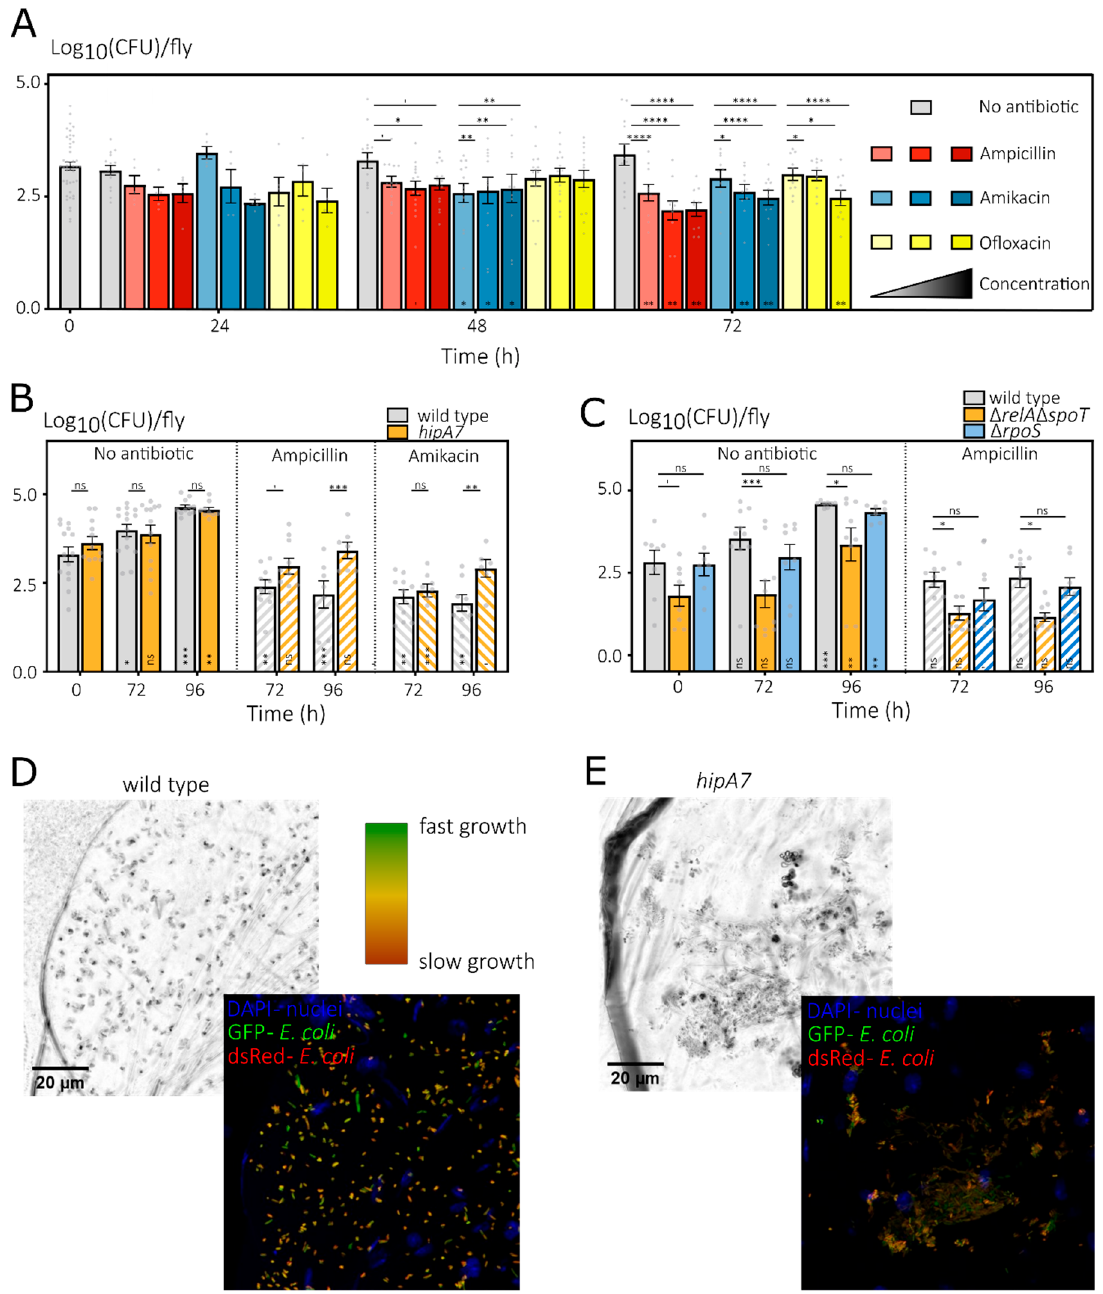
Figure 3. E. coli shows high in vivo antibiotic tolerance inside the gut of D. melanogaster, with in vitro identified persistence mutants showing mixed results during in vivo antibiotic treatments. ( A ) When treating D. melanogaster associated with the SX43 E. coli wild-type strain with AP (red), AM (blue) and OF (yellow) at 3 different concentrations (100, 400 and 1000 for AP and AM or 10, 40 and 100 µg mL − 1 for OF, all in different intensities) via liquid food in the CAFE assay, bacterial loads only start to decrease at 48 h and more consistently at 72 h. Bacterial loads are normalized per fly (means ± SEMs with n ≥ 10 vials as gray points across ≥ 2 independent runs) and an lme with post hoc test shows the significance of the difference compared to the untreated control (gray bars) per time (Dunnett test, above bars) and compared to the untreated start point (Dunnett test, in bars). Nonsignificant comparisons are not annotated as such for visual purposes. ( B ) During treatment with AP and AM (both at 100 µg mL − 1 , hatched bars on the right), the bacterial loads of D. melanogaster associated with the hipA7 mutant (gold) remain higher compared to the loads of those associated with the MG1655 wild-type strain (gray). In contrast, bacterial loads are highly similar in absence of antibiotic treatment (full bars, left). Bacterial loads are normalized per fly (means ± SEMs with n ≥ 6 vials as gray points across ≥ 2 independent runs) and a linear model with post hoc test